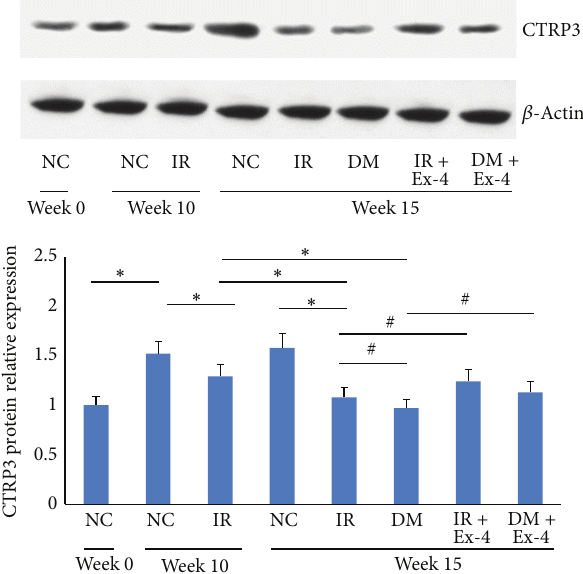
Figure 3: CTRP3 protein expression at the different stages of T2DM pathogenesis. NC: normal control group; IR: insulin resistance group; DM: diabetes mellitus group; IR + Ex-4: insulin resistance plus Exendin-4 treatment group; DM + Ex-4: diabetes mellitus plus Exendin-4 treatment group; ∗ 𝑃 < 0.01 , # 𝑃 < 0.05